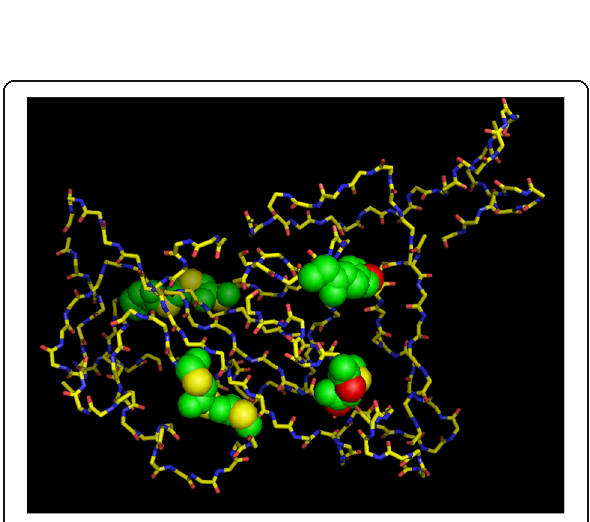
Fig. 2 Kinases/phosphorylation sites of spike receptor-binding domain (RBD). The motifs (spheres) on spike RBD domain (sticks) determined from Scan Prosite revealed cAMP- and cGMP-dependent protein kinase phosphorylation site: “ KRIS; ” protein kinase C phosphorylation site: “ TFK ” and “ TGK; ” cell attachment sequence: “ RGD